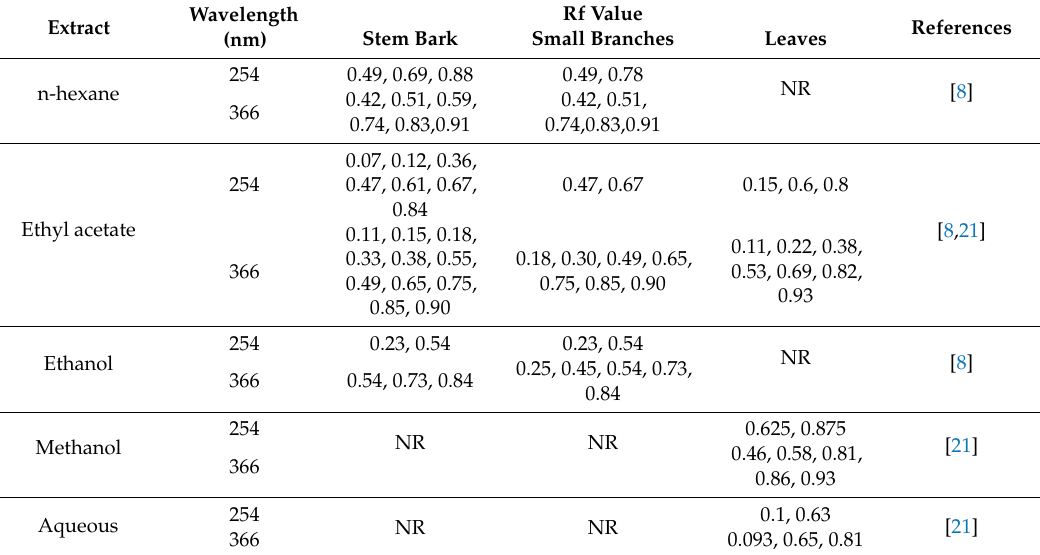
Table 5. HPTLC profile of various extracts of di ff erent parts of M.